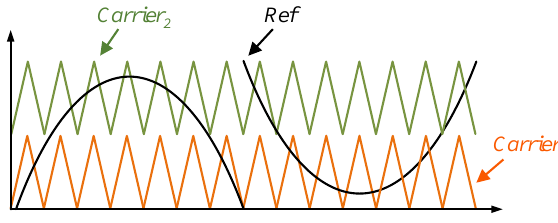
Figure 4. Adapted reference signal used in the modulation strategy.